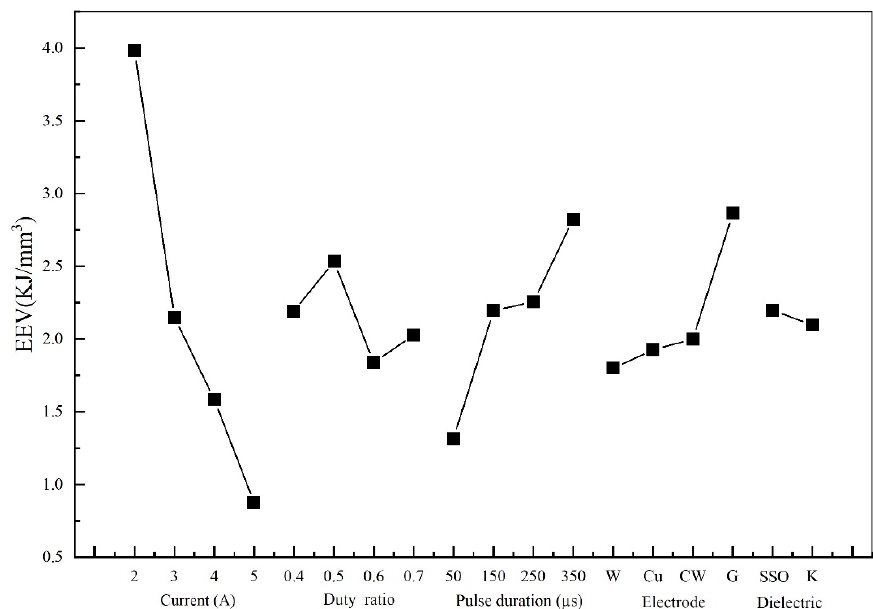
Figure 5. The influence of current, duty ratio, pulse duration, electrode and dielectric on EEV. The process of pulse discharge generates a high temperature in the machining area.